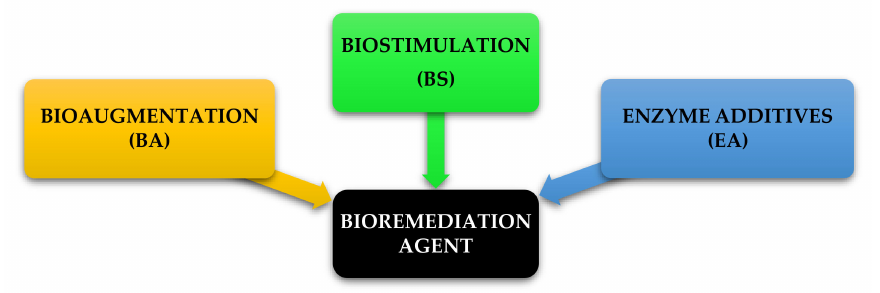
Figure 9. Bioremediation agents under National Oil and Hazardous Substance Pollution Contingency Plan (NCP),